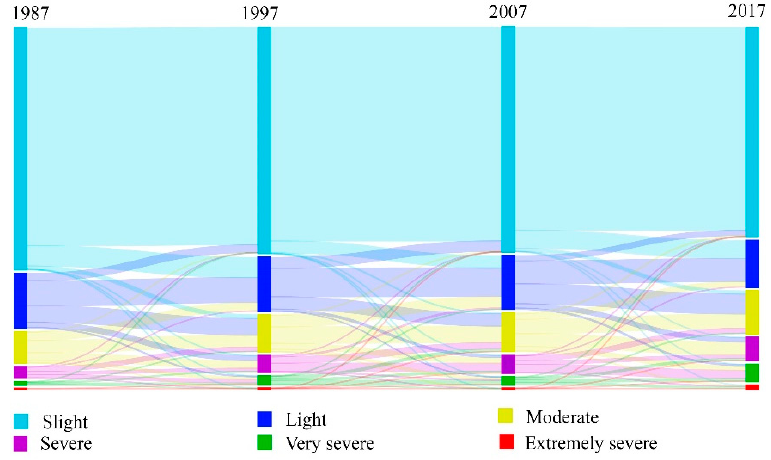
Figure 6. This figure shows the soil erosion change for 1987, 1997, 2007, and 2017. The stacked bars’ colors represent soil erosion class. The stacked bars’ height represents area of soil erosion class. The width of the lines represents the transfer areas of soil erosion class.